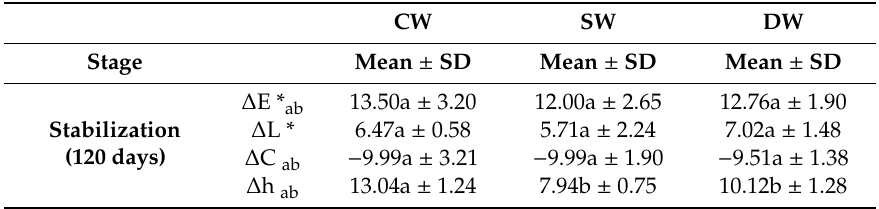
Table 3. Color di ff erences for each wine (CW, SW and DW) considering the end point of the stabilization with respect to the initial point (day 0, wood addition). For each parameter, di ff erent letters in the same row indicate statistical di ff erences (Tukey test, α = 0.05).